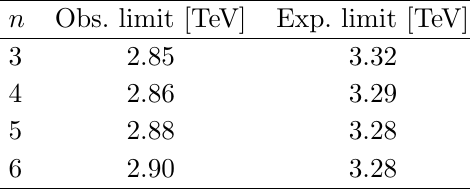
Table 3 . The 95% CL observed and expected lower limits on M D as a function of n , the number of ADD extra